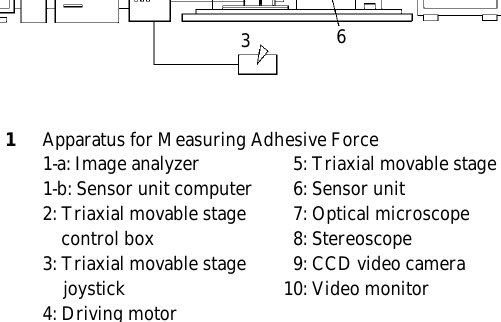
Fig. 1 Apparatus for Measuring Adhesive Force 1-a: Image analyzer 05: Triaxial movable stage 1-b: Sensor unit computer 06: Sensor unit 2: Triaxial movable stage